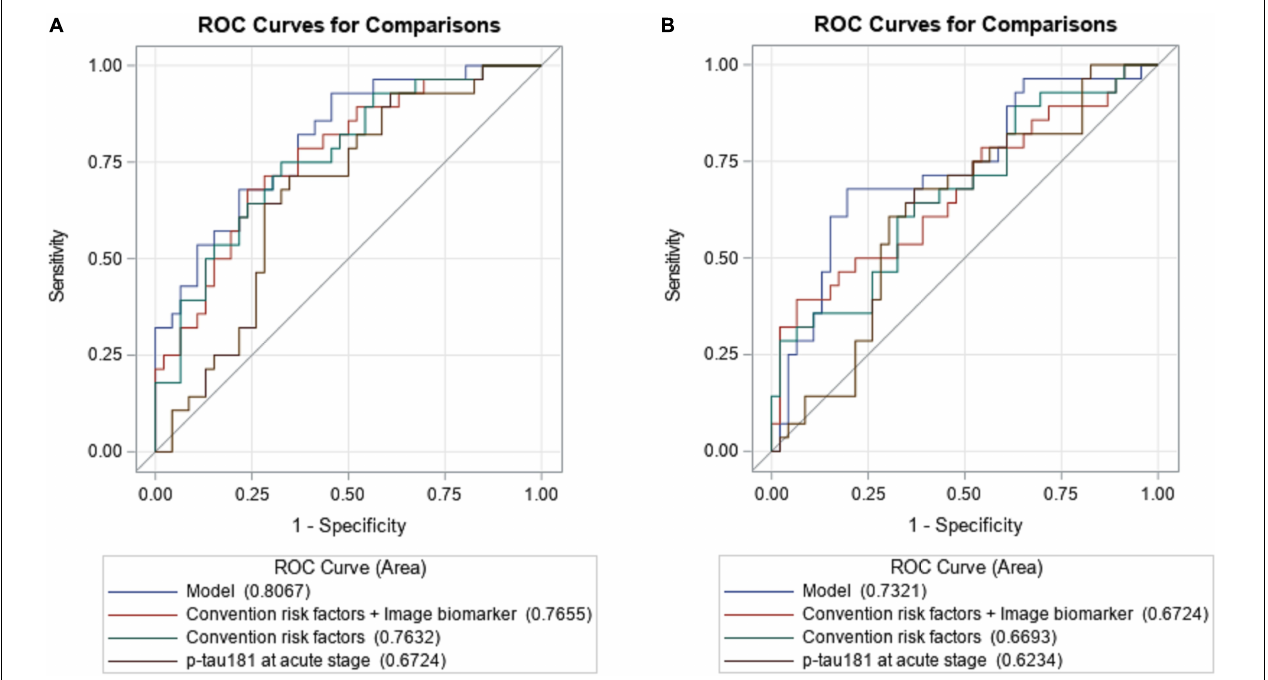
FIGURE 2 | The area under the receiver operating characteristic of the p-tau181 predicting PSCI at 3 (A) and 12 months (B) , respectively, when compared to conventional risk factors with image markers.